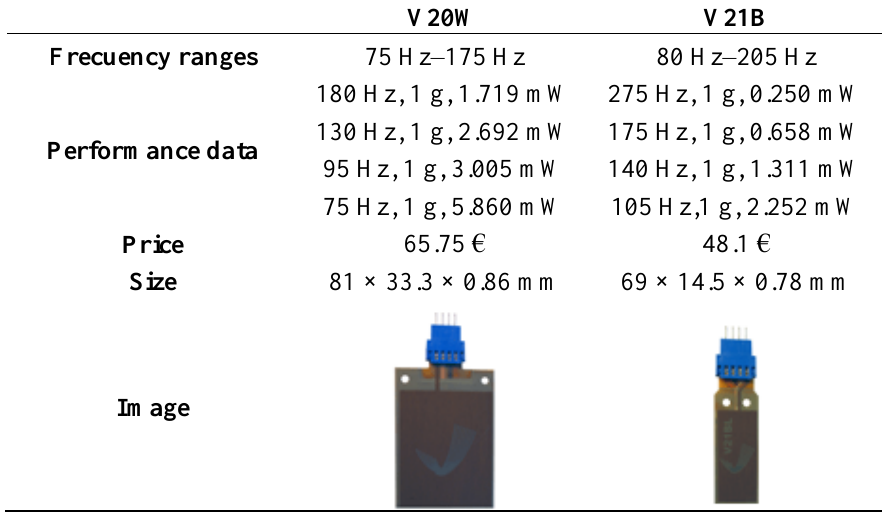
Table 8. Technical characteristics of V20W and V21B piezoelectric devices from Mide.